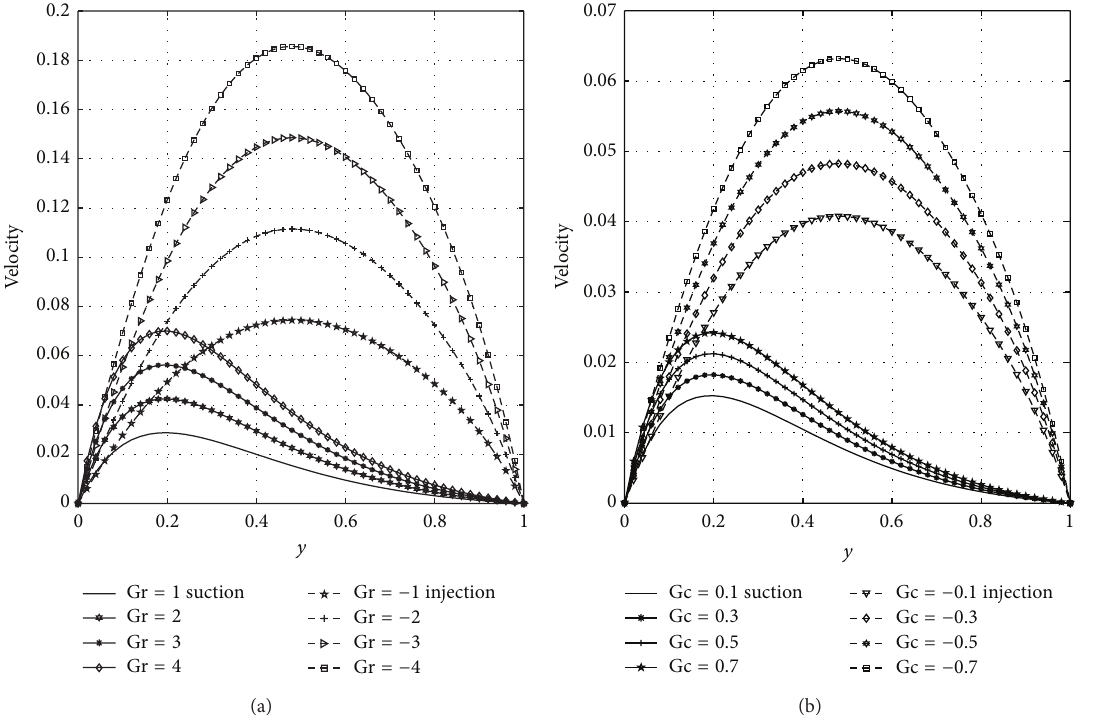
Figure 8: Effects of thermal Grashof number (Gr) and mass Grashof number (Gc) on